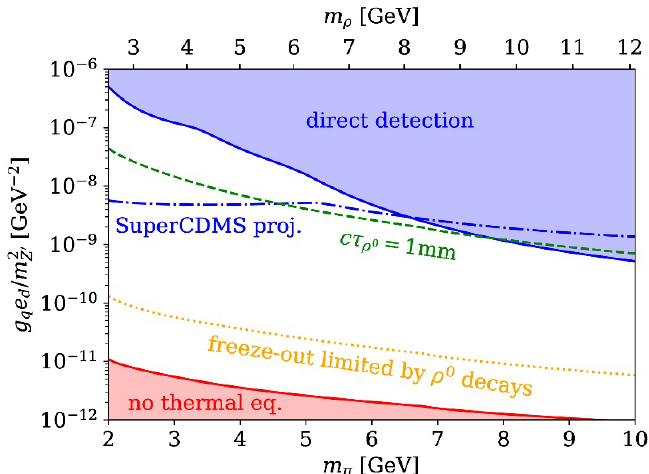
Figure 2 . Constraints on the dark pion mass m (cid:25) and e(cid:11)ective coupling g q e d =m 2 analysis of di(cid:11)erent direct detection experiments (see text for details). The second x -axis at the top indicates the values of m (cid:26) for which the observed DM relic abundance can be reproduced for a (cid:25) { (cid:26) coupling of g = 1. The relic density calculation requires the (cid:26) 0 mesons to be in equilibrium with the SM until the end of freeze-out, which is satis(cid:12)ed for the parameter region above the orange dashed line. Below the green dashed line, the (cid:26) 0 decay length may be